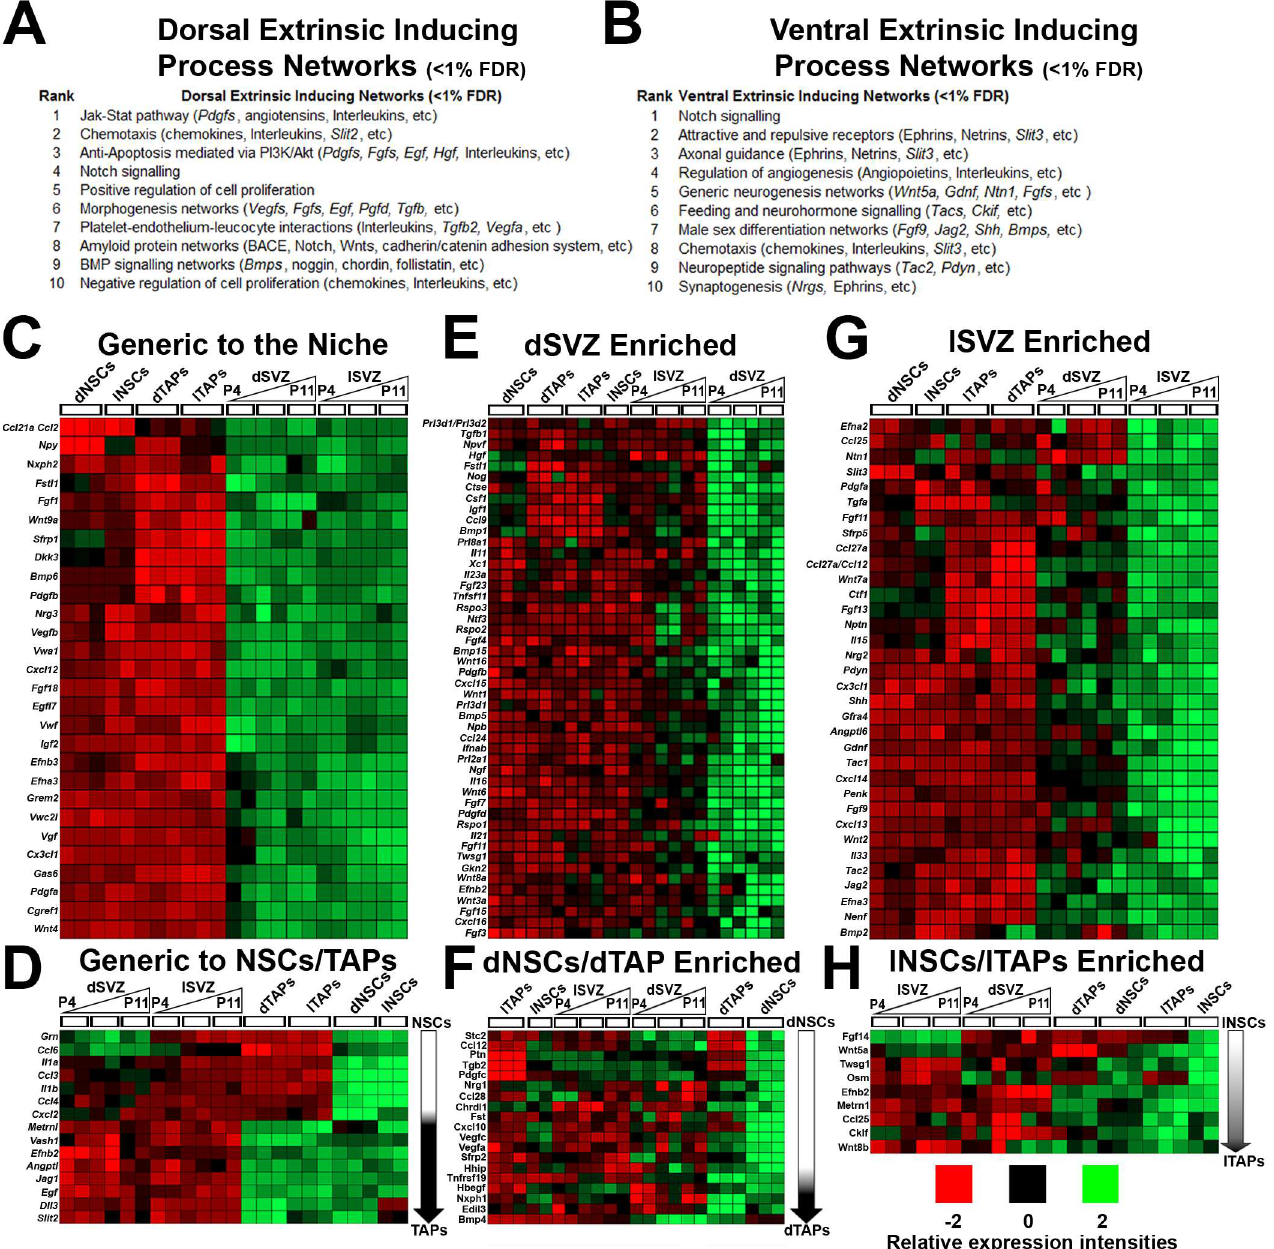
Fig 1. Spatial expression profiles of secreted signaling factors in subventricular zone (SVZ) microdomains. (A, B) Significantlyfiltered genesin each region-derived sample were analyzedon GeneGo Metacore for process networksand ranked numerically accordingto their false discovery rate (FDR) significance( < 1%). NB: process networkscategorieswere shortenedto fit. ( C, D) Heatmapsof genes generic and stable within microdomains across the varied time points are plotted, including those common in isolated neuralstem cells (NSCs)/transient amplifying progenitors (TAPs) (D) . ( E-G) Heatmaps of genesenrichedin region-specific microdomains (generallystable temporal expression) versus the adjacent microdomain and NSCs/TAPs. The same was performed for regionspecific NSCs/TAPs (F, H) . Note: the overlappingexpressionprofiles for region-specific NSCs with TAPs. dNSCs, dorsal NSCs; dTAPs, dorsal TAPs; dSVZ, dorsal SVZ; lNSCs, lateral NSCs; lTAPs, lateral TAPs; lSVZ, lateral SVZ.